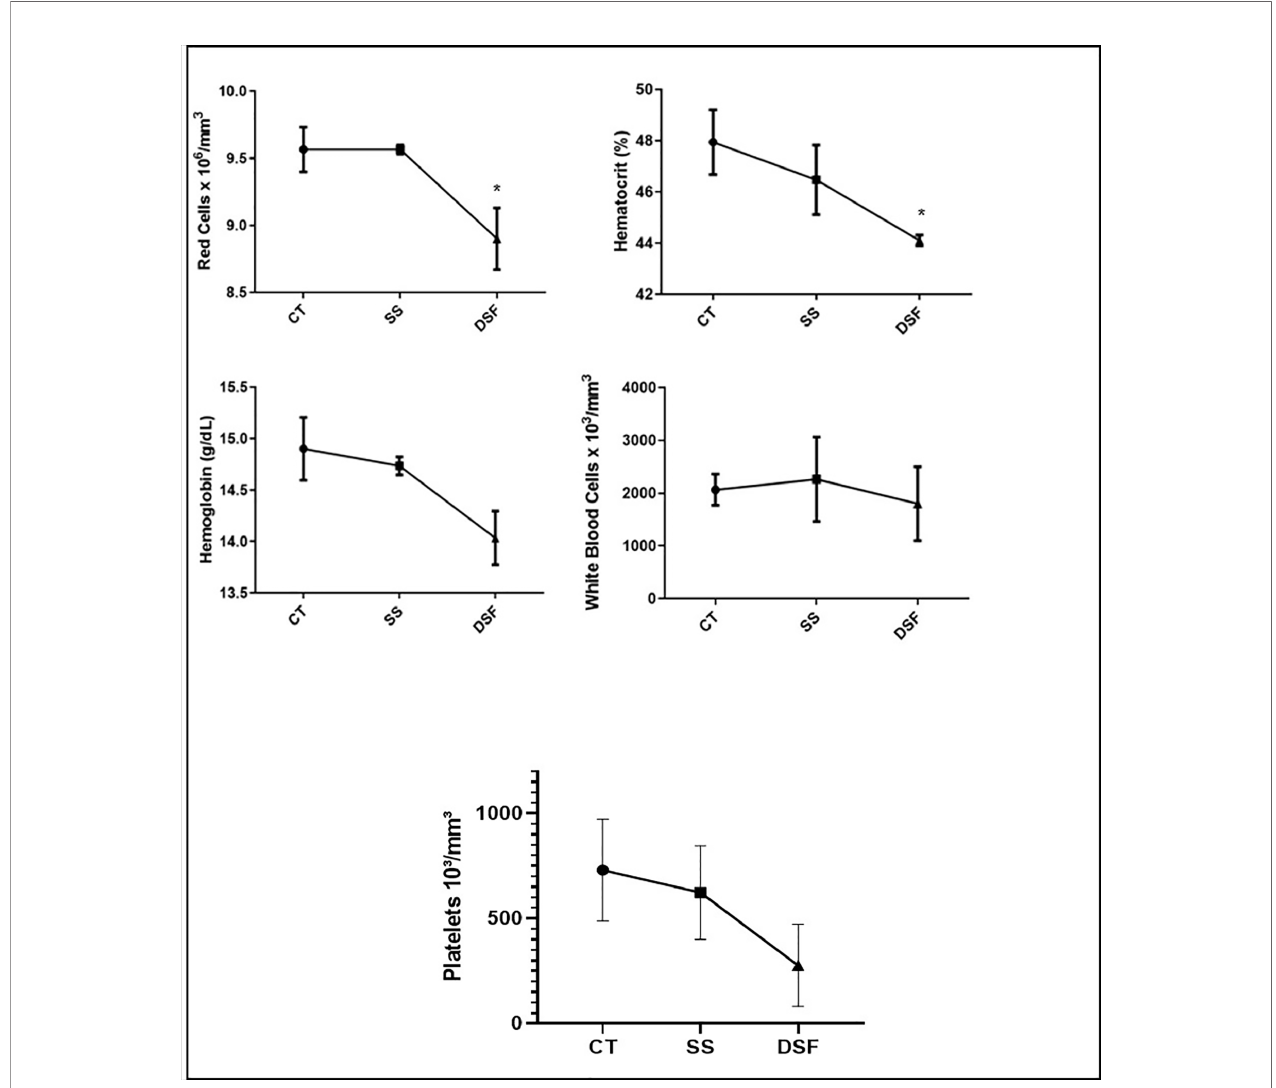
FIGURE 4 | Hematological values obtained for the groups of mice studied (CT = control group; SS = treated with sterile saline and DSF = group treated with 1 ppm peracetic acid). The results are expressed as mean and standard deviation. *p <